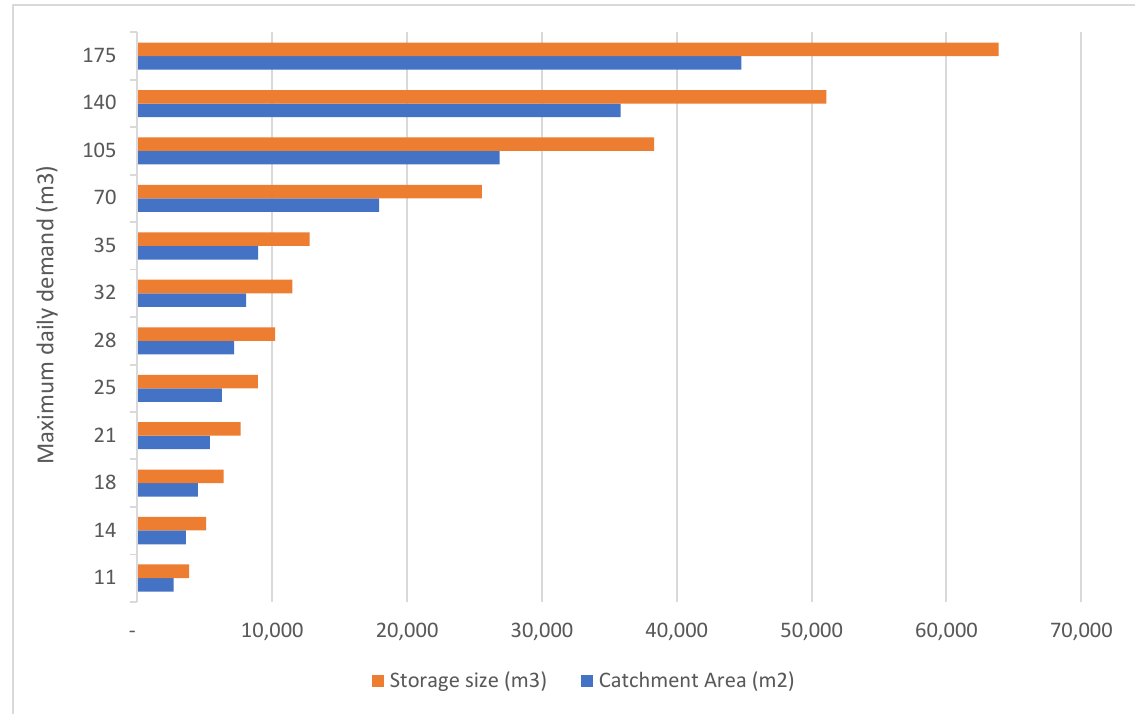
Figure 9. Illustration of water demand and resulting maximum catchment (m 2 ) and storage (m 3 ) sizes for securing the demand from roof catchments .